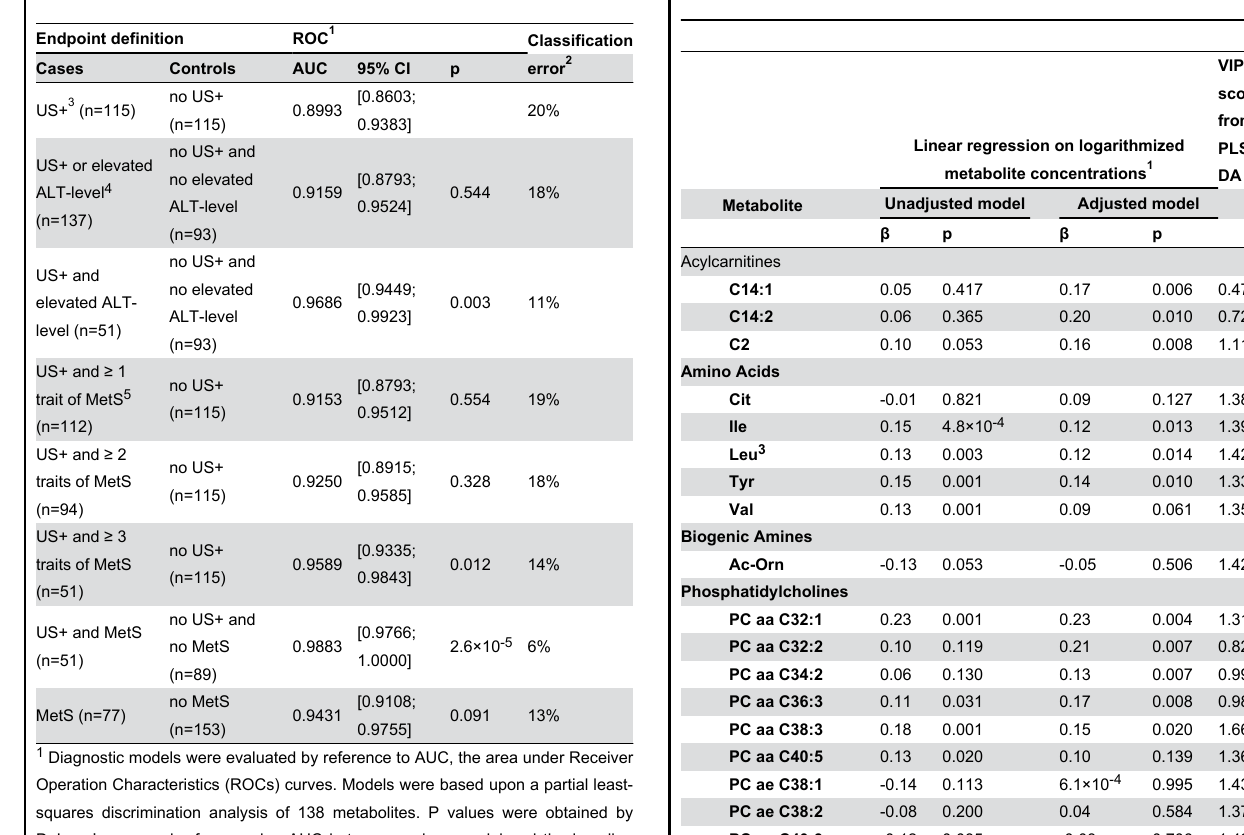
Table 3. Diagnostic accuracy of 138 metabolites for different endpoint definitions of fatty liver disease, and for metabolic syndrome.